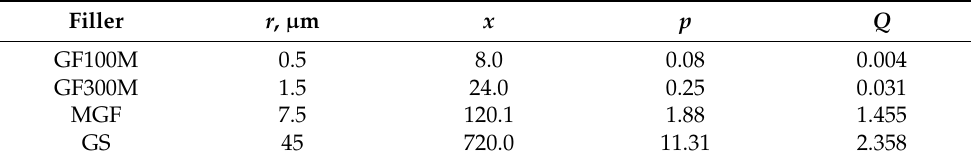
Table 3. Calculated values of x , p and Q for investigated samples. Filler r , µ m x p